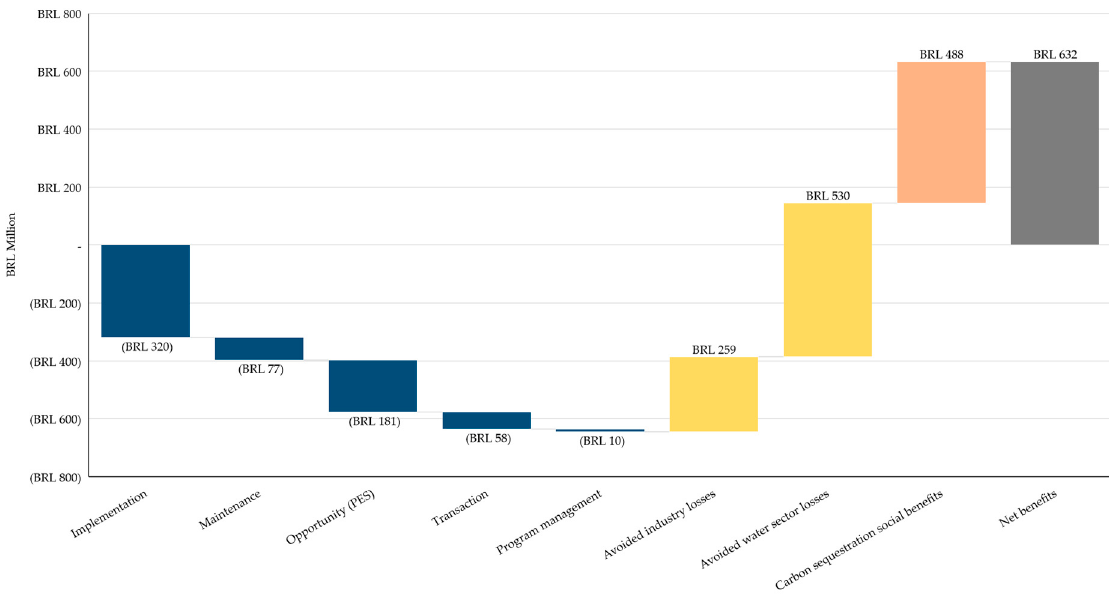
Figure 9. Full lifecycle (35-year) NPV if the water supply to the industrial and water sectors and the avoided social cost of carbon (SCC) are counted as benefits (Scenario 3). Colors indicate costs (blue bars), benefits (yellow and orange bars), and net benefits (grey bar).